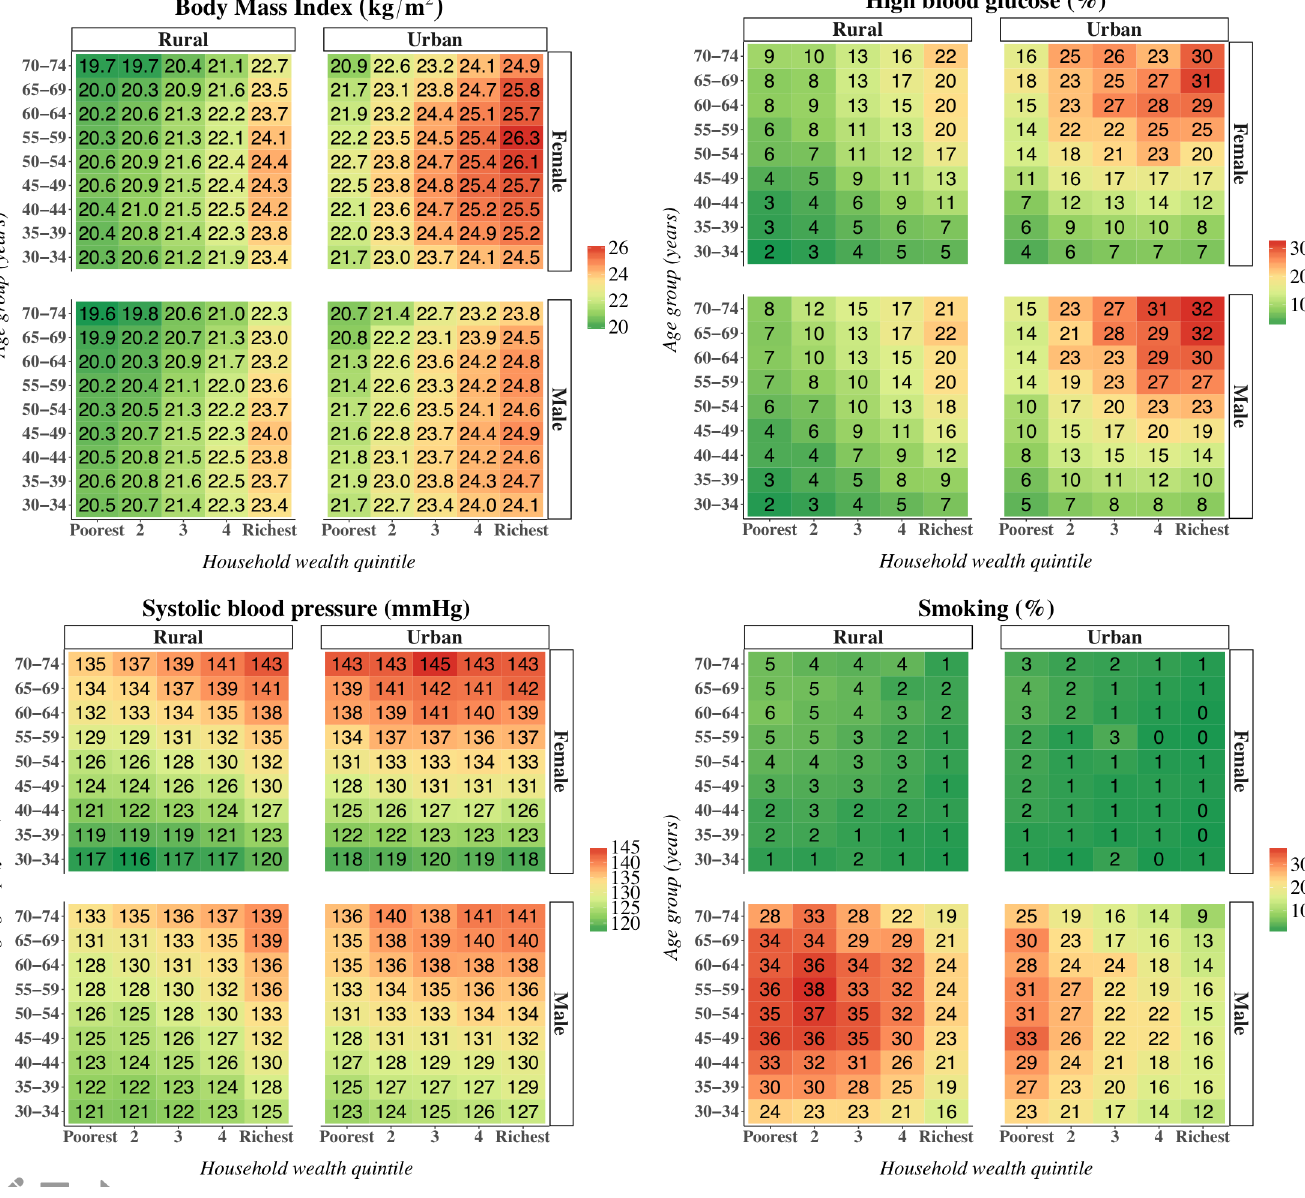
PLOS Medicine| https://doi.org/10.1371/journal.pmed.1002581 June 19,